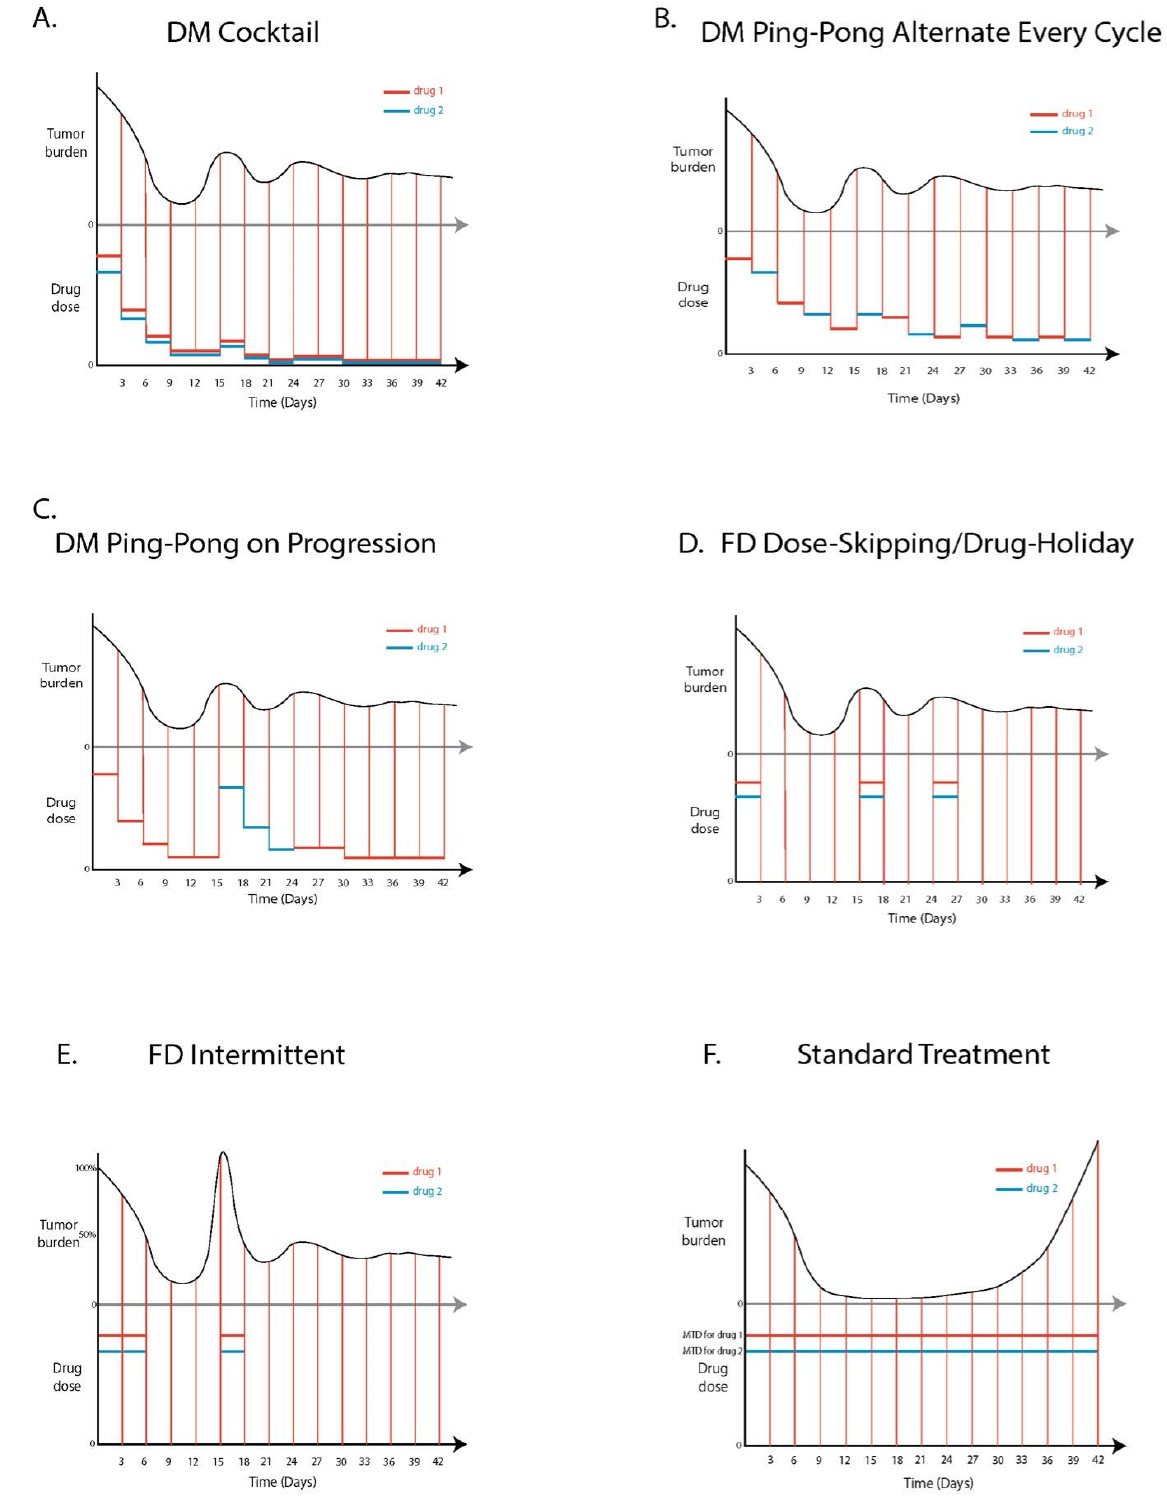
Figure 3. Two-drug adaptive therapy protocols, comparing variations of dose modulation (DM) and fixed dose (FD) adaptive therapy. Each panel shows on top, an example of how tumor burden might fluctuate over time, and below, how the dosing of the two drugs would be adjusted in response to the change in the tumor burden. Tumor burden is measured every 3 days (indicated with vertical lines). ( A ) DM Cocktail increases the dose of both drugs if the tumor is growing, and reduces the dose of both drugs if the tumor is shrinking. ( B ) DM Ping-Pong Alternate Every Cycle uses one